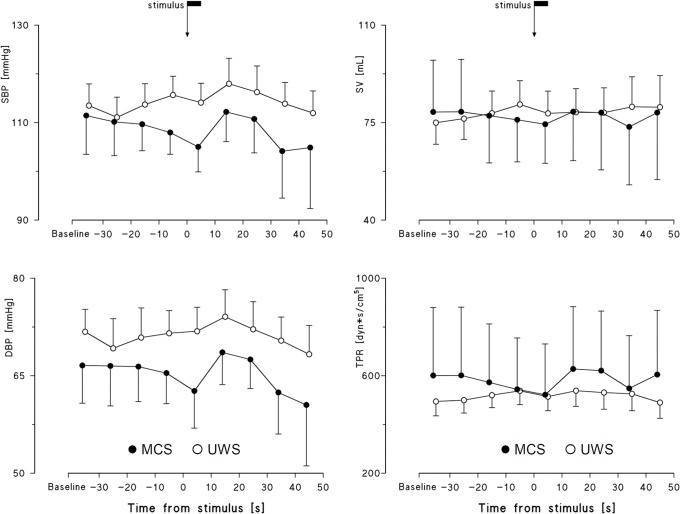
SBP, DBP, SV and TPR profiles around the noxious stimulus.Data as mean and sem; the arrow indicates the stimulus application. No differences vs. baseline were significant at p<0.05.